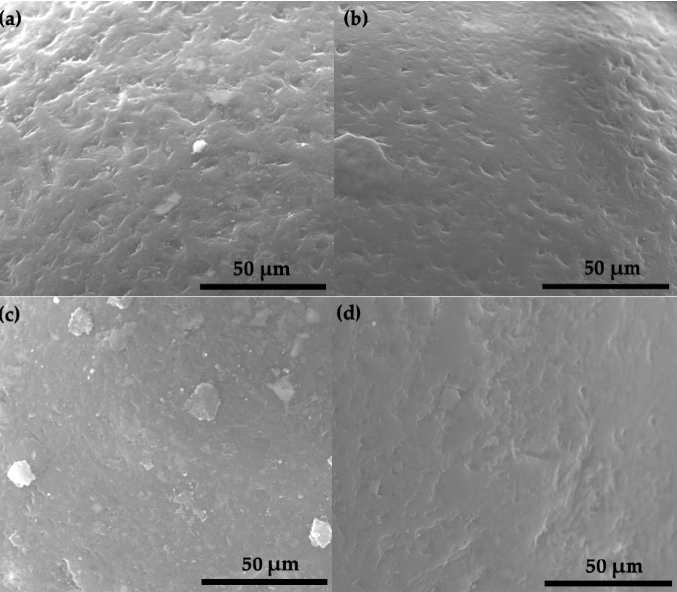
Figure 9. SEM micrographs of the HDPE MPs after visible-light photocatalytic degradation for 50 h by C,N-TiO 2 in the ( a ) tert-Butanol, ( b ) isopropyl alcohol ( c ) tiron, and ( d ) copper nitrate scavengers.